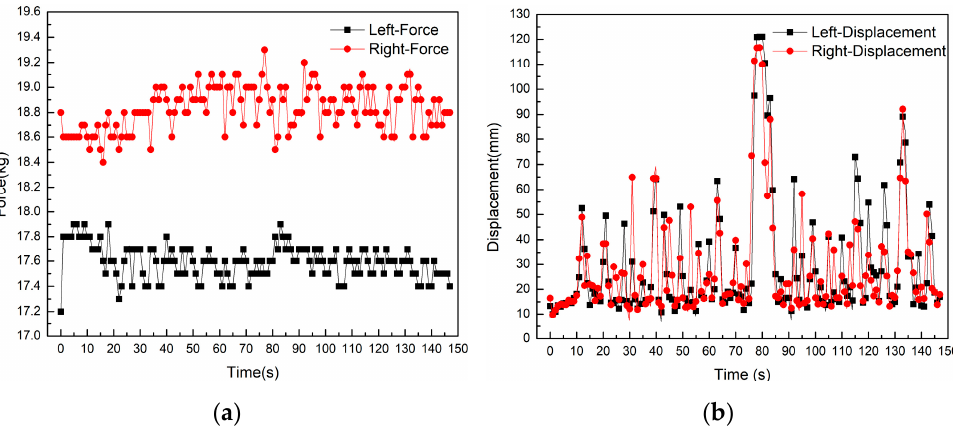
Figure 19. ( a ) Force curve of the straight walking; ( b ) displacement curve of the straight walking. In situ steering is a function that is often used by the patients during the rehabilitation process. Under the condition that the initial BWS value is constant, three sets of repeated experiments were carried out for the left and right in situ steering in the experiment. The data curves are shown in Figure 20a,b and Figure 21a,b. The body posture corresponding to the left turning is the left shoulder backward and the right shoulder forward. The displacement data curve in Figure 20b shows that most of the time during the whole steering process the value of the right displacement curve is at the maximum value. The value of the displacement curve on the right is stable within the fluctuation range of 10–20 mm. In the volunteer experiment, there was a short-term turning and discontinuity problem, and the robot produced a turning stop and direction swing. Correspondingly, there was a large increase in the left displacement curve within 10~50 s, and then it returned to the fluctua- tion range. The displacement curve on the right has a significant decrease, and then it returns to the maximum range. The body posture corresponding to the right turning is the right shoulder back and the left shoulder forward. It can be further seen from the dis- placement data curve in Figure 21b that the value of the left displacement curve is always at the maximum state during the whole turning process. The value of the displacement curve on the right fluctuates in a larger range within the interval of 15–70 mm. During the experiment, when turning, the volunteers moved slowly and discontinuously. Every time the body turned one angle, they made a very short pause, and the right slider would slide to the initial position. Therefore, the displacement curve on the right fluctuates in a larger interval. This confirms that the human-computer interaction system can correctly recog- nize the movement posture information of the human body and feed it back to the system interface through the data curve. In this experiment, the BWS value is constant, and the BWS values on the left and right sides are in the range of 17–18 kg and 18–19 kg, respectively. It can be seen from Figure 20a that the average value of the left side BWS when turning left is about 17.53 kg. The average BWS value on the right is about 18.58 kg. It can be also seen from Figure 21a that the average value of the right side BWS while turning right is about 18.91 kg. The average BWS value on the left is about 17.44 kg. For the BWS value of the same side of the